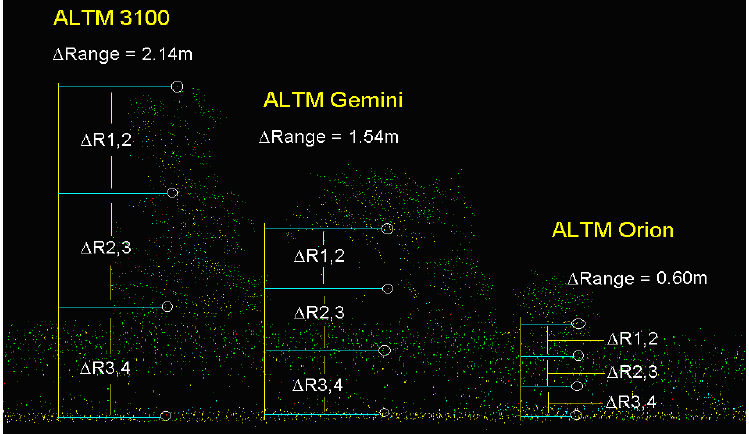
Figure 5. Evolution of minimal vertical target discrimination capabilities for ALTM series of airborne lidar